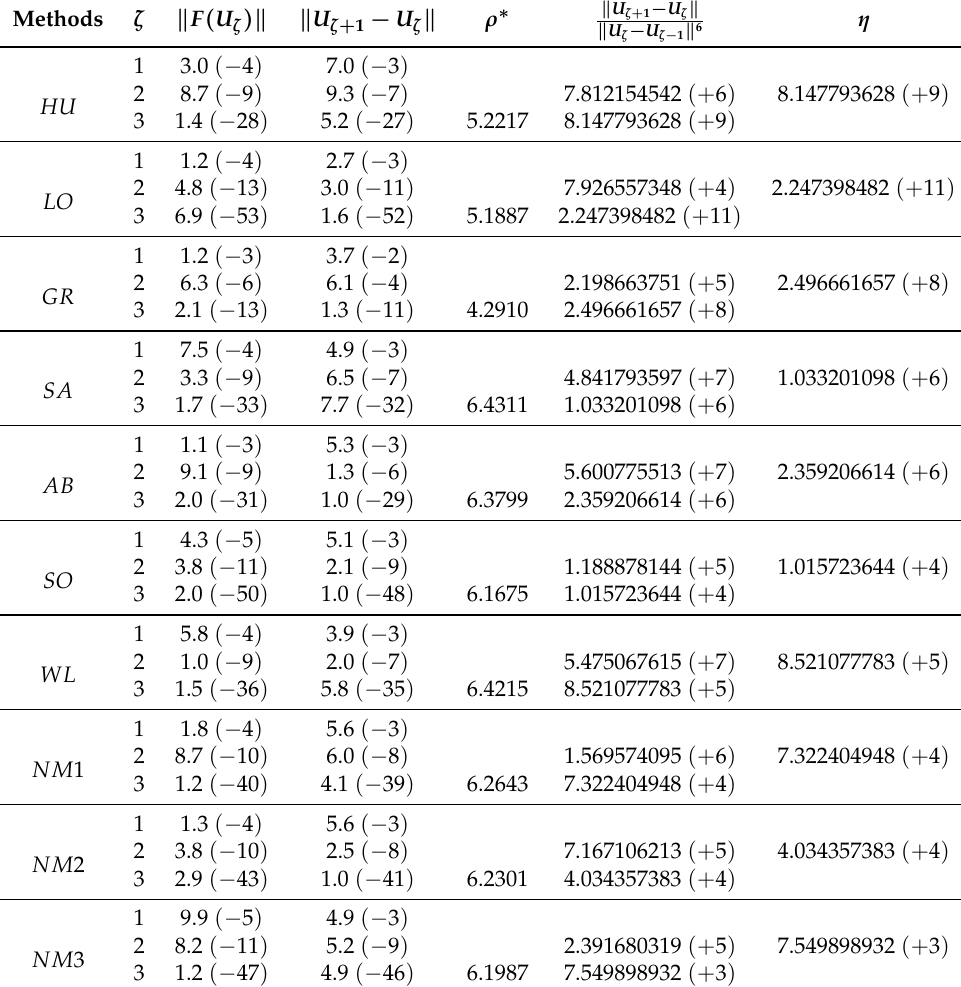
Table 4. Conduct of different techniques in kinematic synthesis problem 3.